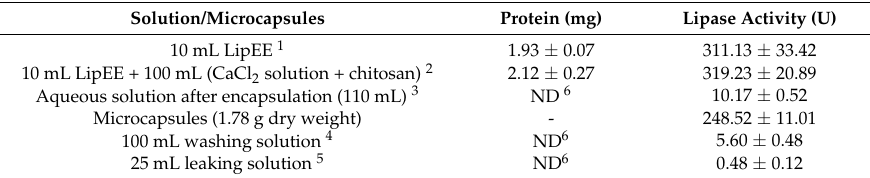
1 LipEE: Lipase enzyme extract (cell-free medium); 2 Control solution: LipEE + calcium chloride and chitosan, without forming the beads (no sodium alginate); 3 The aqueous solution obtained after adding 10 mL of LipEE with sodium alginate to 100 mL of calcium chloride solution with chitosan and removing the beads formed after the complexation time; 4 distilled water used to wash the beads after formation; 5 Buffer solution after immersing the beads for 10 min in phosphate buffer (pH 7.0, 50 mM); 6 ND: not detected in the detection range of the method (100–1000 µ